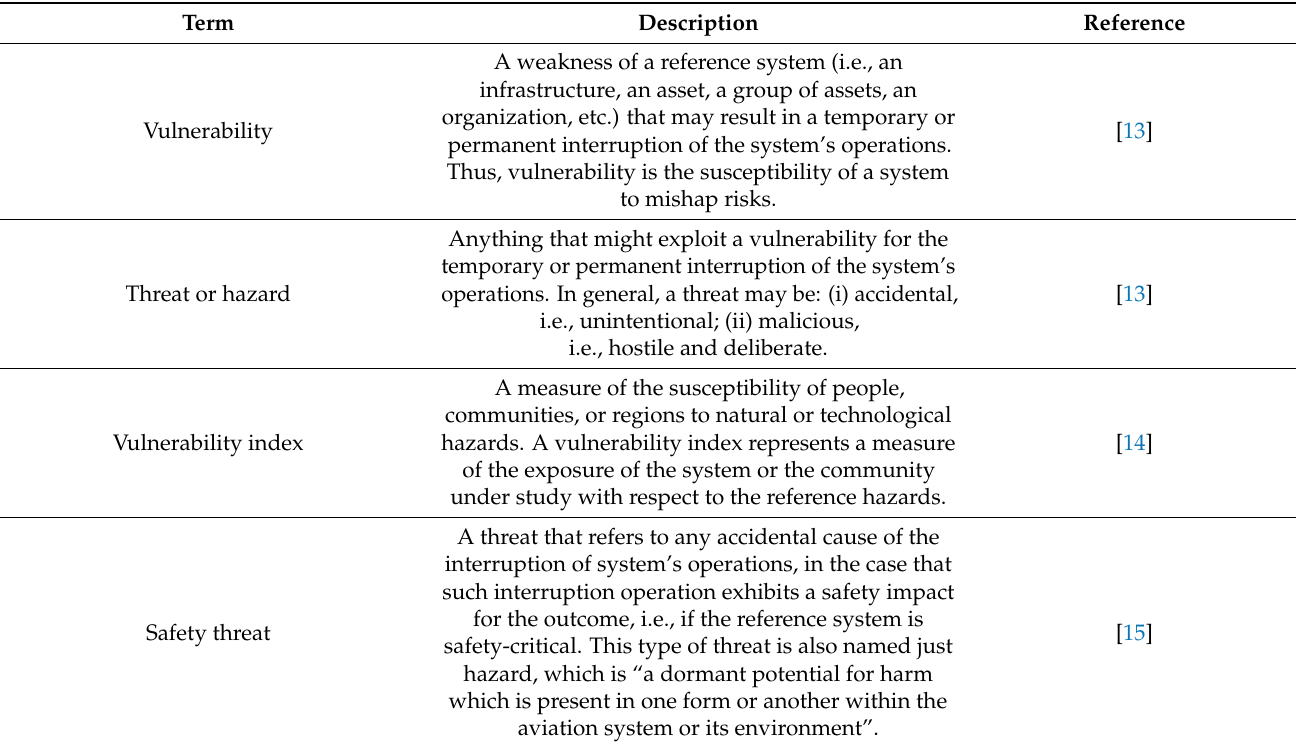
Table 1. Key terms for risk